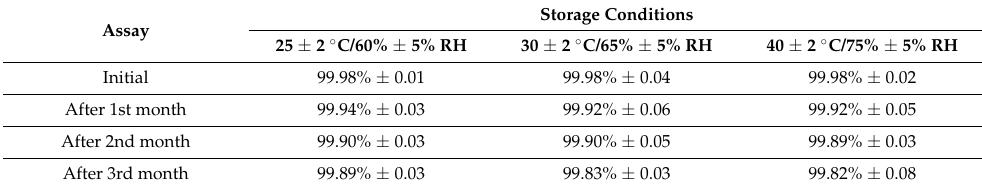
Table 11. Assay of stability samples (n =